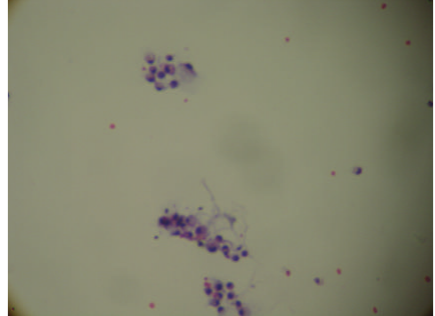
Figure 1: Cytology of cerebral spinal fluid showing clusters of adenocarcinoma cells.